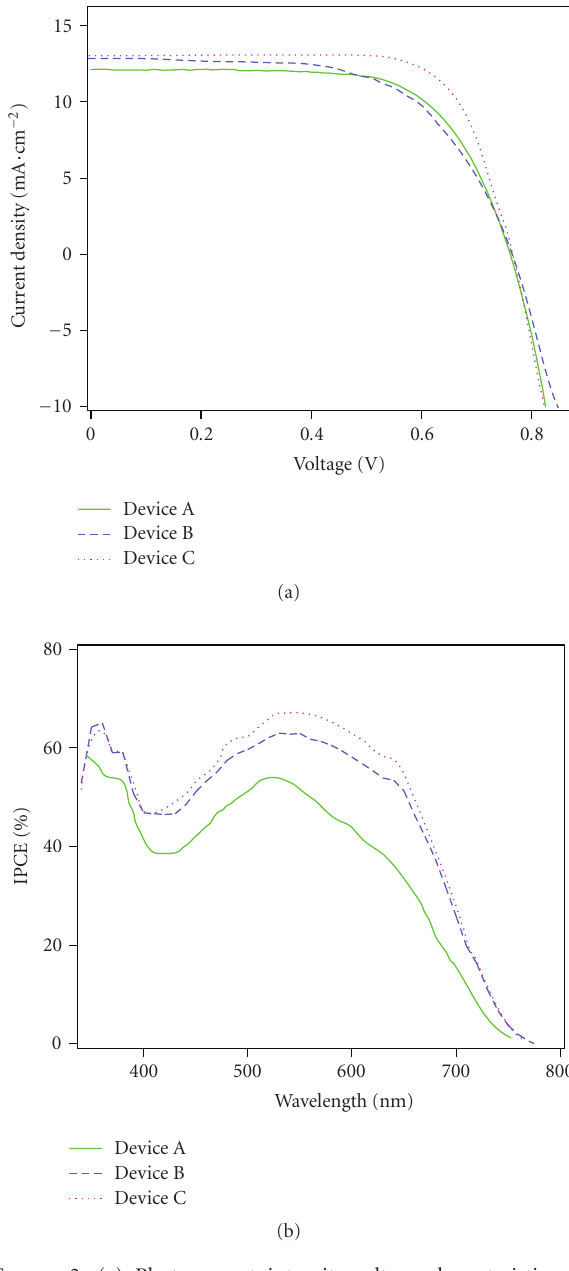
Figure 2: (a) Photocurrent intensity-voltage characteristics for devices A, B, and C, measured at 1 sun (1000W · m − 2 ), AM 1.5 global sunlight illumination. (b) Photocurrent action spectra of the same